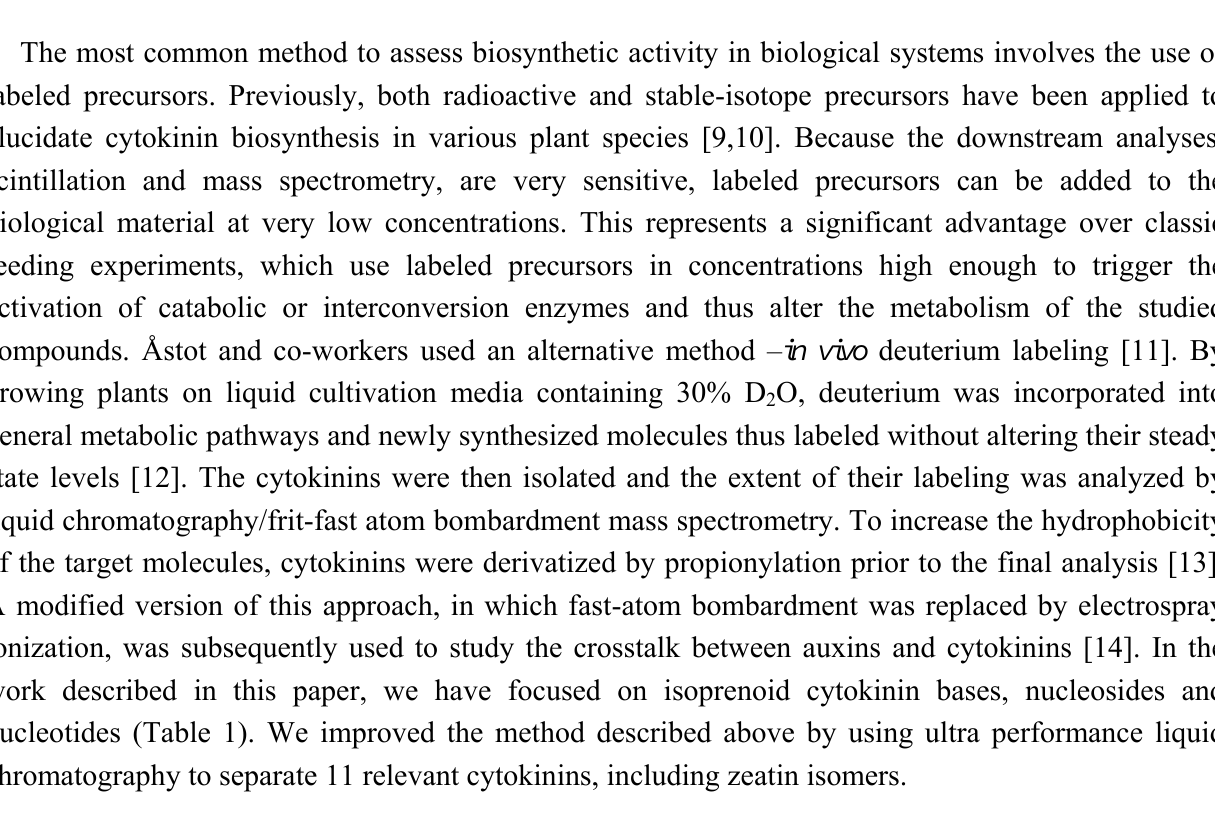
Table 1. Structures, common names and abbreviations of the compounds used in this study.